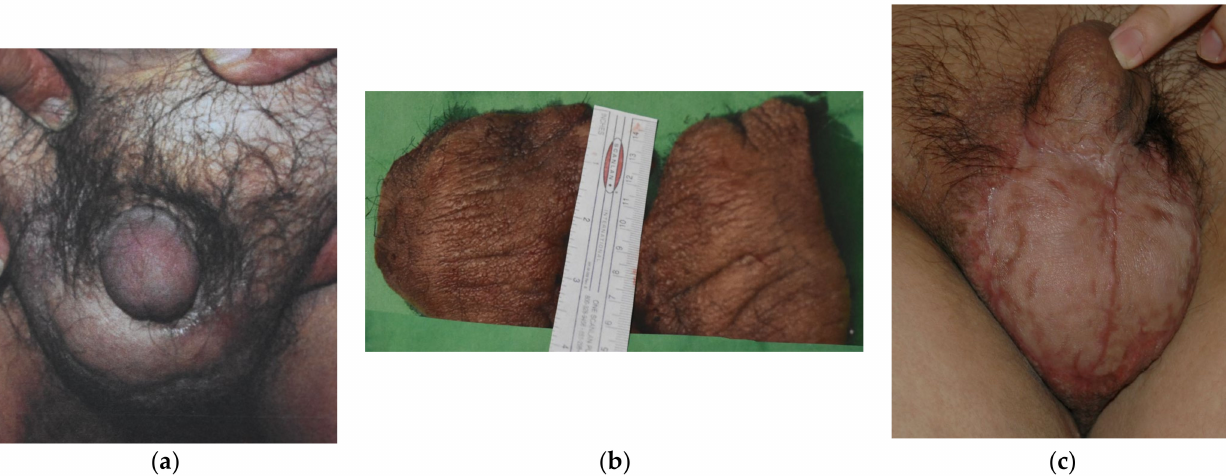
Figure 3. A male patient, 45 years old, presented to our unit with GL stage III involving the scrotal area after radiation for retroperitoneal malignancy. The scrotal lymphedema was almost completely hiding the penis. ( a ) Excisional surgery and scrotum reconstruction with meshed STSG were performed: the picture ( b ) shows indurated skin and subcutaneous tissue due to chronic inflammation that were excised. One year after surgery, there was no more inflammation and discharge in the genital area. The urine passage was smooth ( c